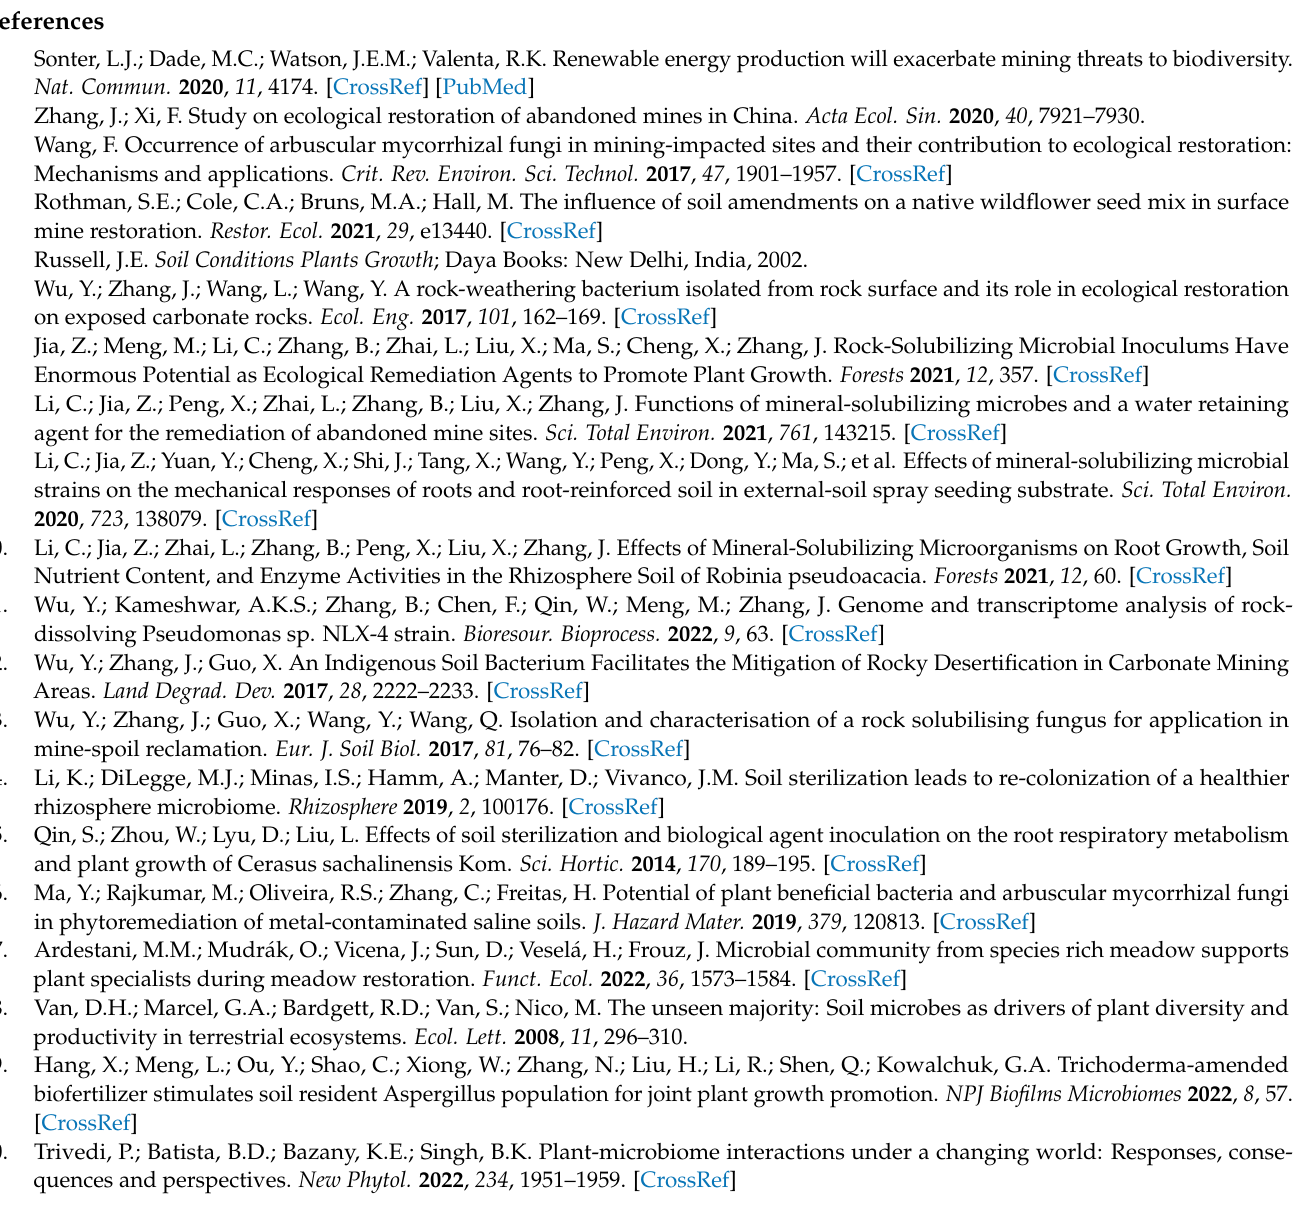
Figshare with the identifier https://figshare.com/account/home#/projects/147141, accessed on 21 February